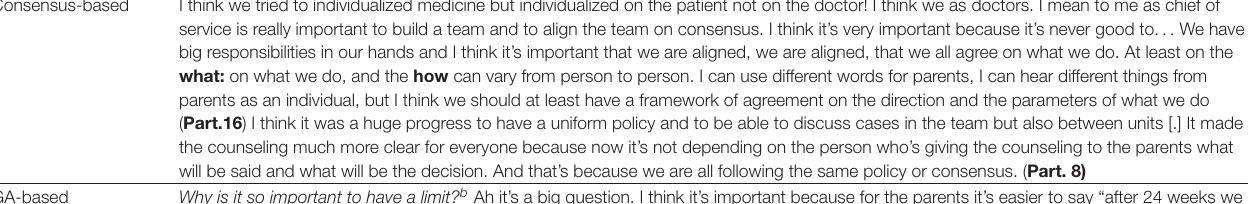
TABLE 2 | Illustrative quotes: neonatologists’ clinical-ethical decision-making a .